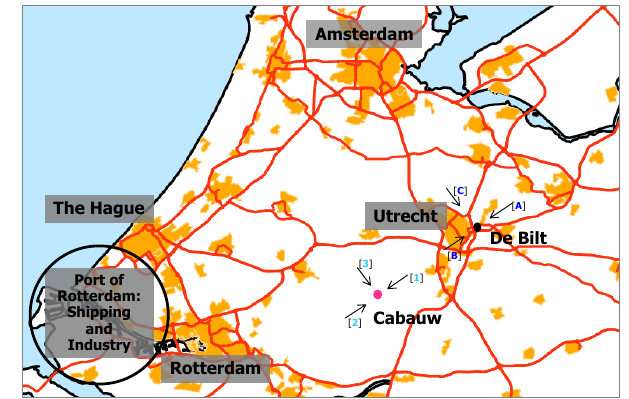
Figure 12. Map of the Randstad region in the Netherlands. Cabauw and De Bilt are 22km apart, and have the city of Utrecht in between. The arrows indicate wind directions discussed in the Sect. 4.4, and correspond to the arrows shown in Fig.